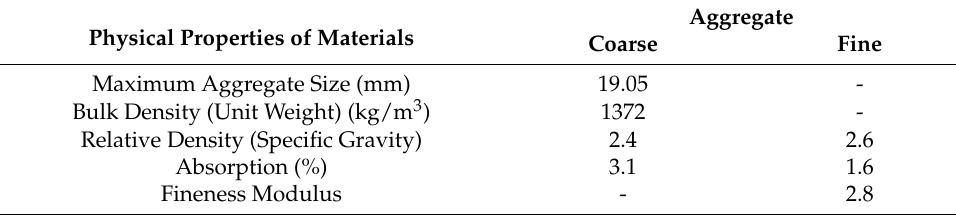
Table 1. Results of the characterization of the